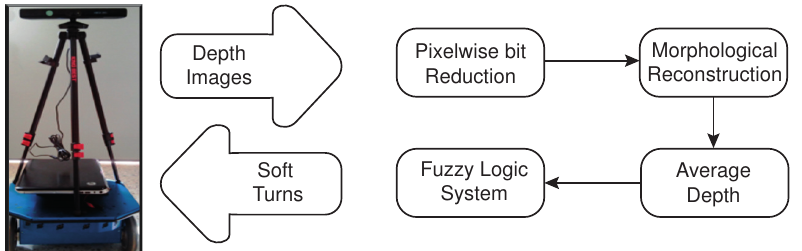
Figure 4. Diagram of the reactive navigation system, which has four modules: pixel-wise bit reduction, morphological reconstruction, average depth, and fuzzy